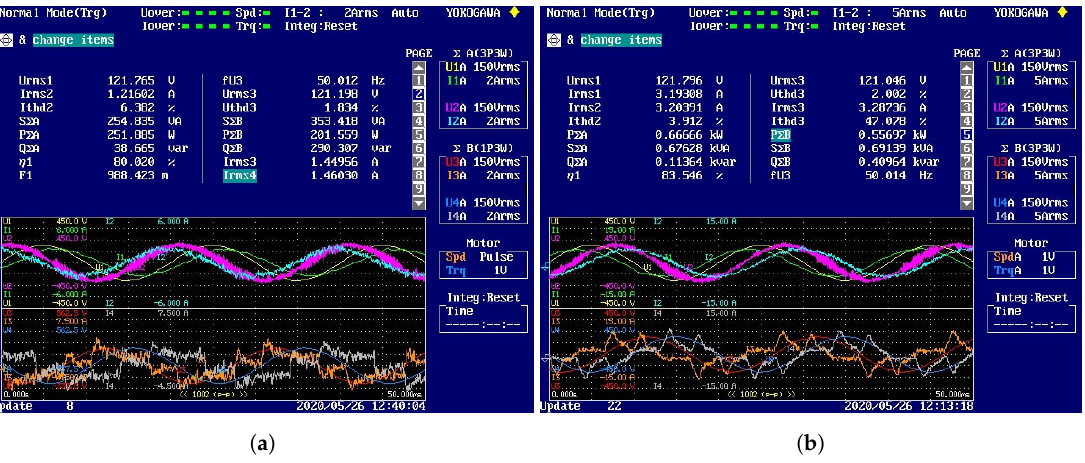
Figure 13. Power analyzers results during asymmetric load-sharing: ( a ) UPS1 providing 25% of the load power; ( b ) UPS2 providing 75% of the load power.